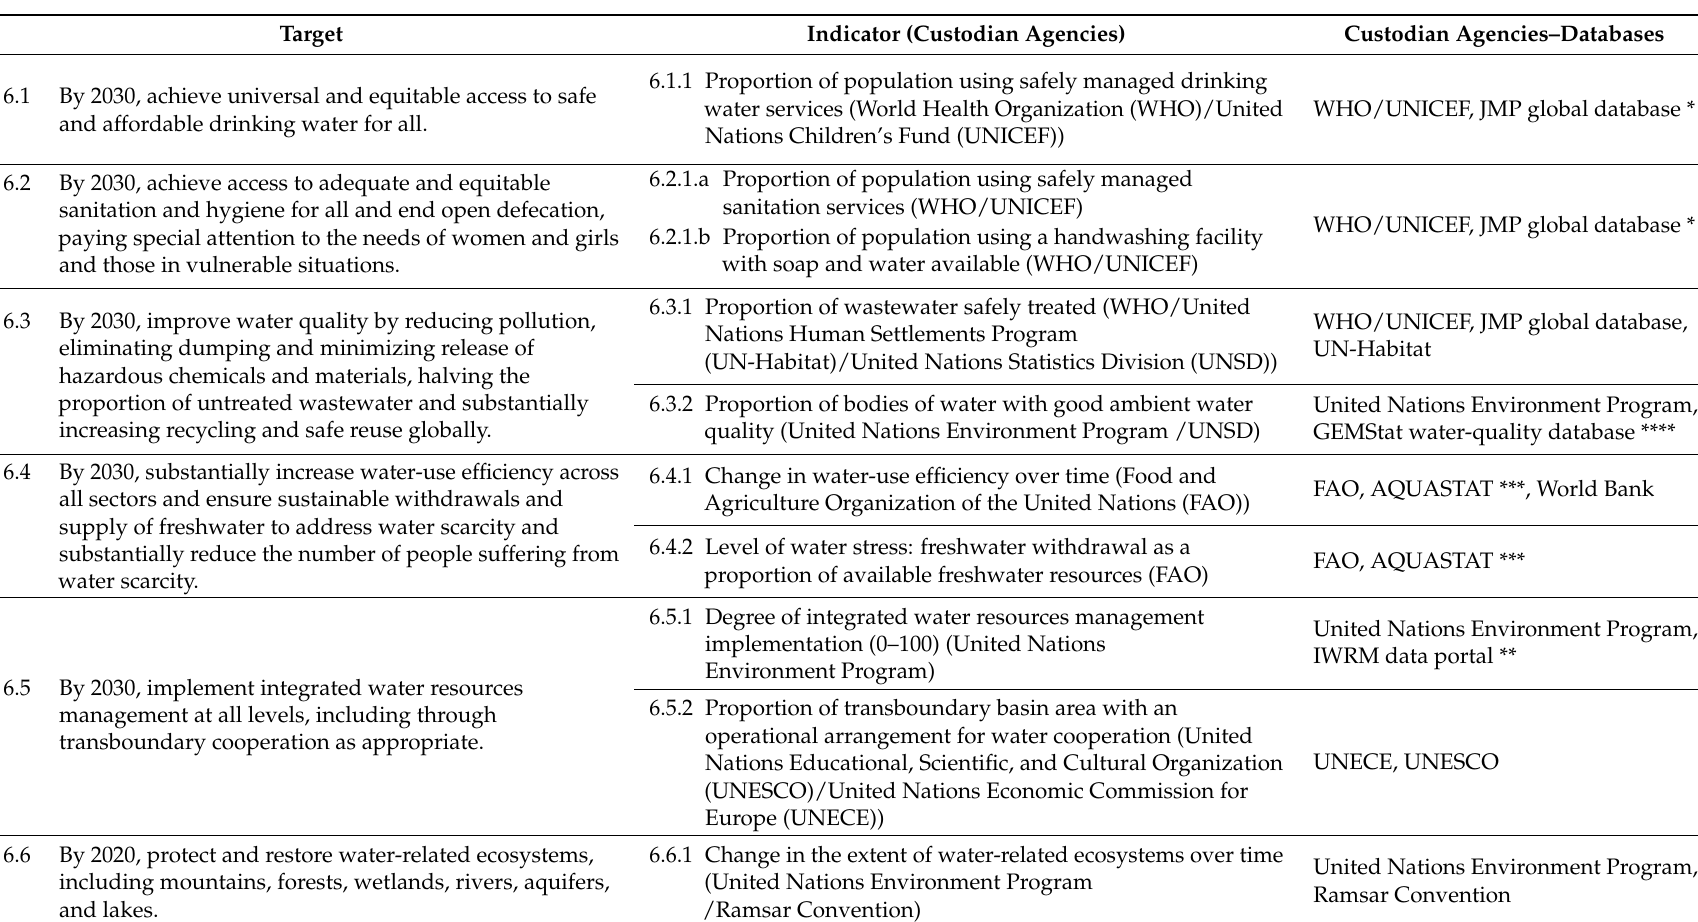
Table 1. SDG 6 targets, indicators, and custodian